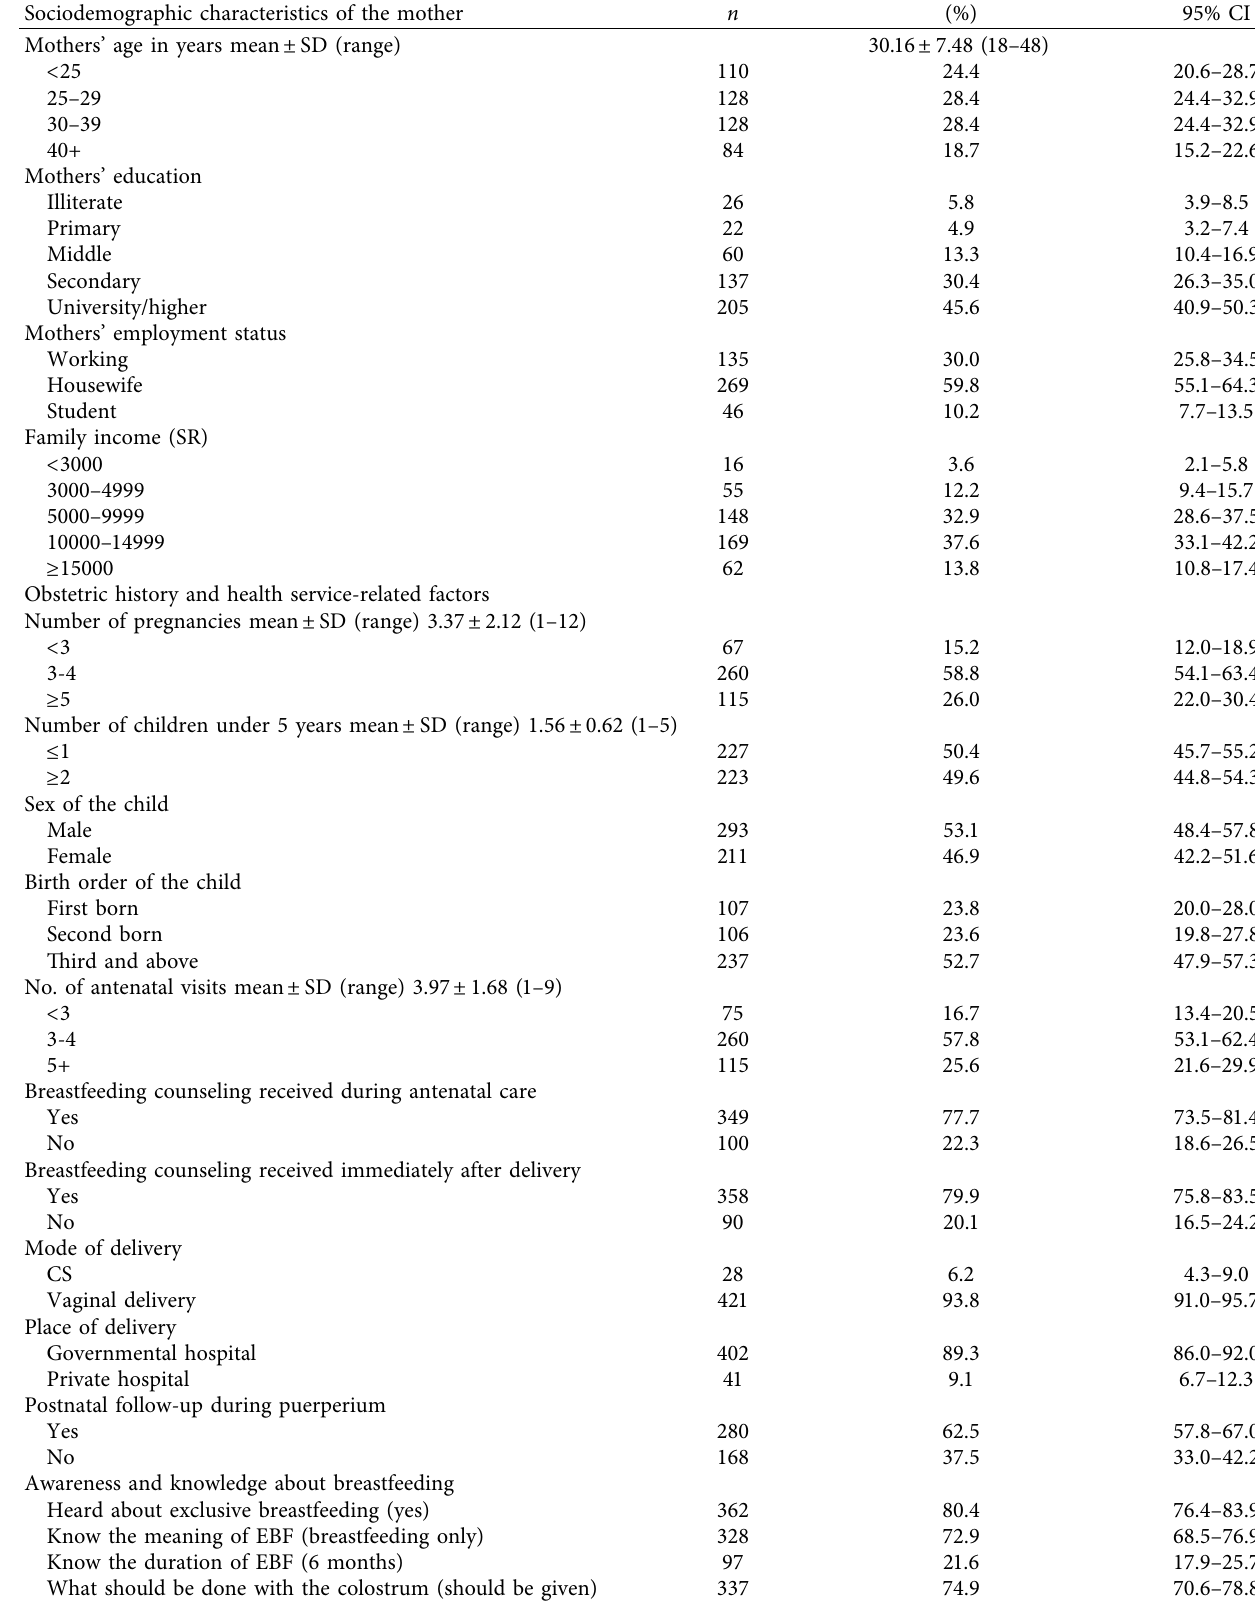
Table 1: Sociodemographic, maternal, child, and health service characteristics reported by the study participants in Hail city, Saudi Arabia,